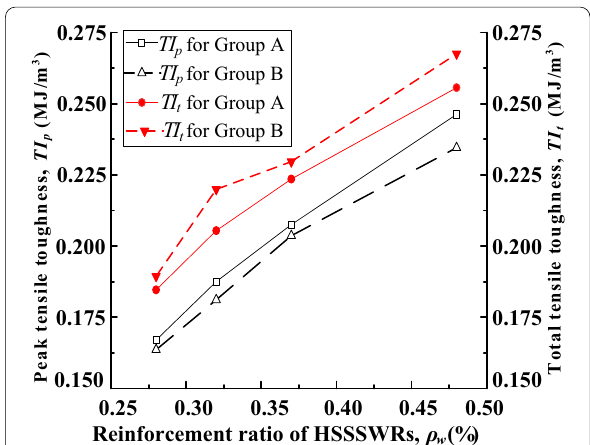
Fig. 8 Relationship of tensile toughness index and reinforcement ratio of